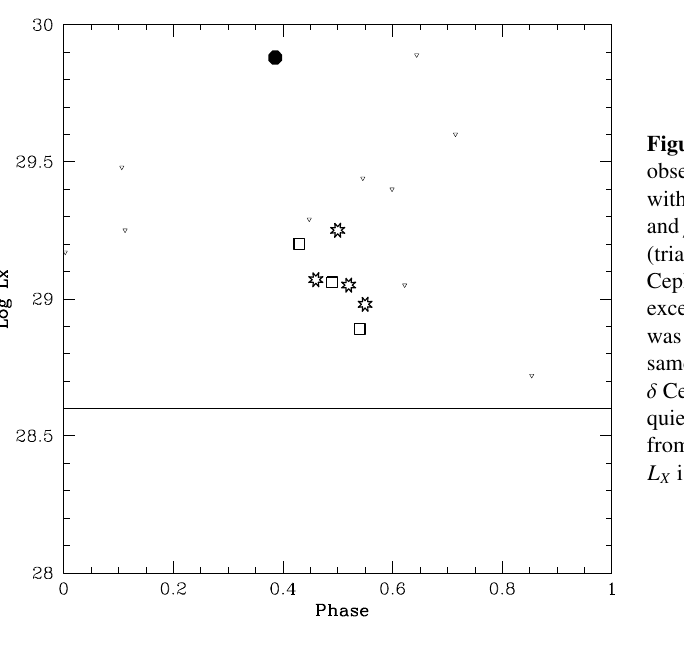
Figure 1. Random phase XMM observations of Cepheids, compared with observations of δ Cep (asterisks) and β Dor (squares). Upper limits (triangles) were found for all Cepheids in the XMM observations, except V473 Lyr (filled circle), which was observed at maximum radius, the same phase as the increased flux in δ Cep. The horizontal line is the quiescent level of X-rays for δ Cep from 9 observations at other phases. L X is in ergs sec − 1